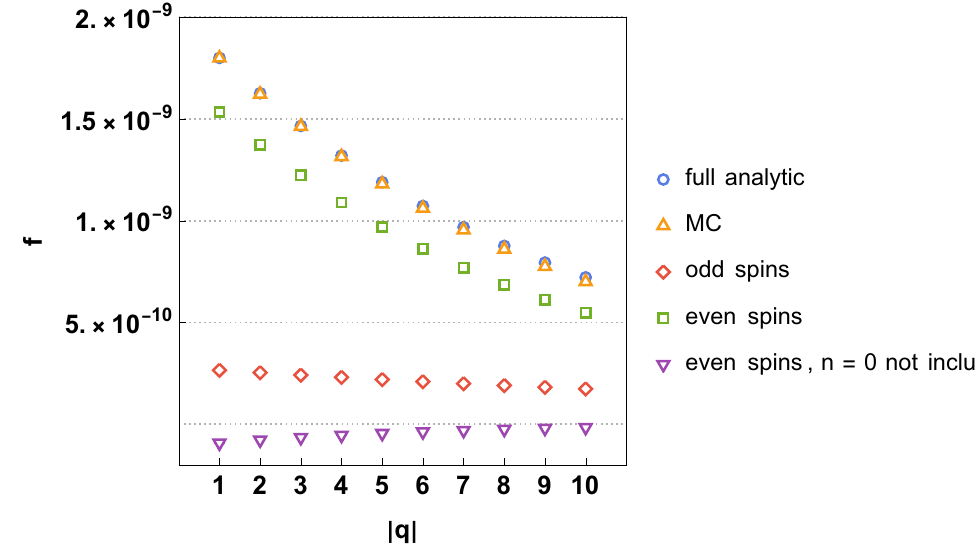
Figure 3: Gluon Green’s function dependence on | q | for fixed | ~k a | , | ~k b | , θ a , θ b , θ q and Y . In order to match the MC results both odd and even conformal spins must be